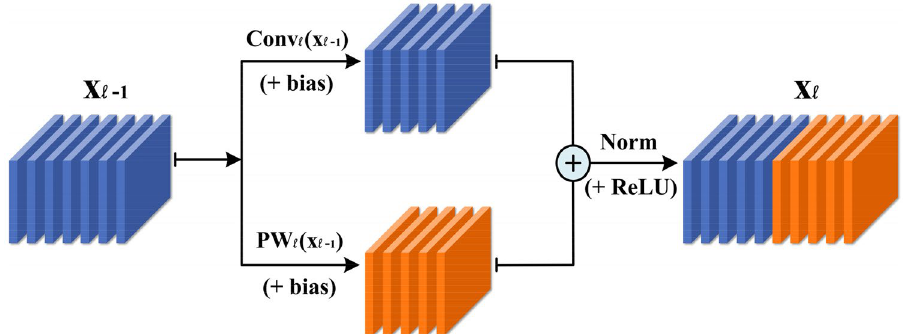
Figure 8. The parallel structure of the RAC module.